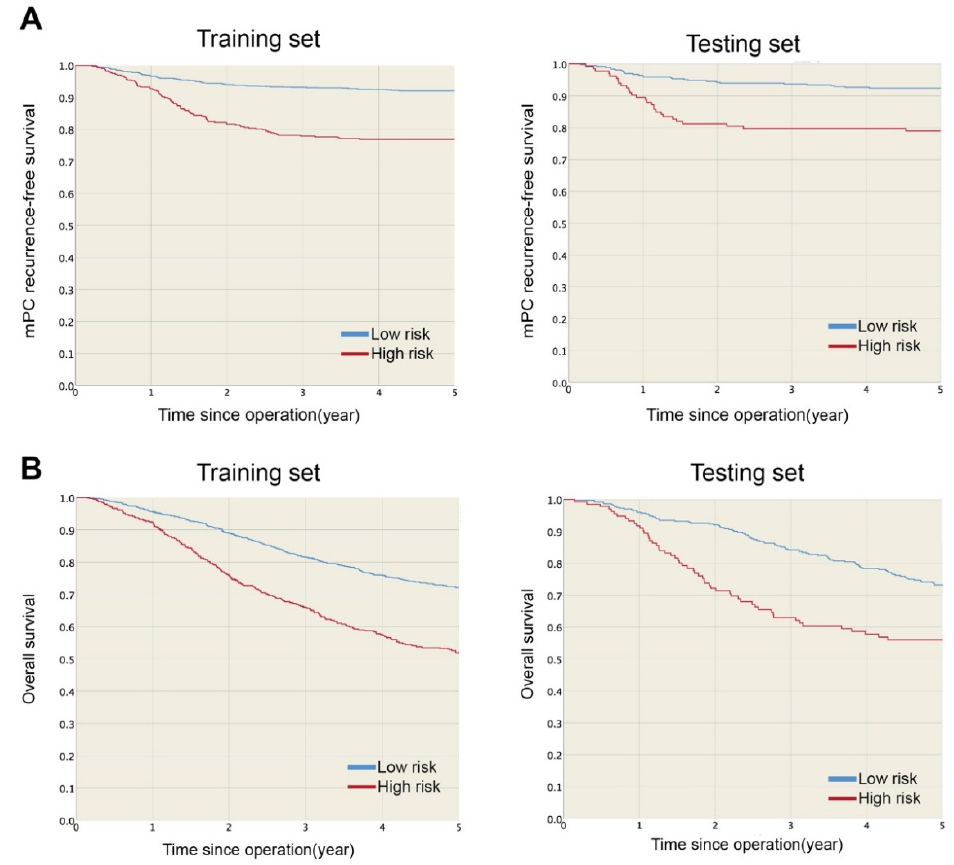
Figure 3. ( A ) mPC recurrence-free survival and ( B ) overall survival were significantly higher in low-risk than high-risk group in training and testing sets.